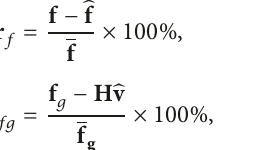
corresponding control voltages and relative errors of